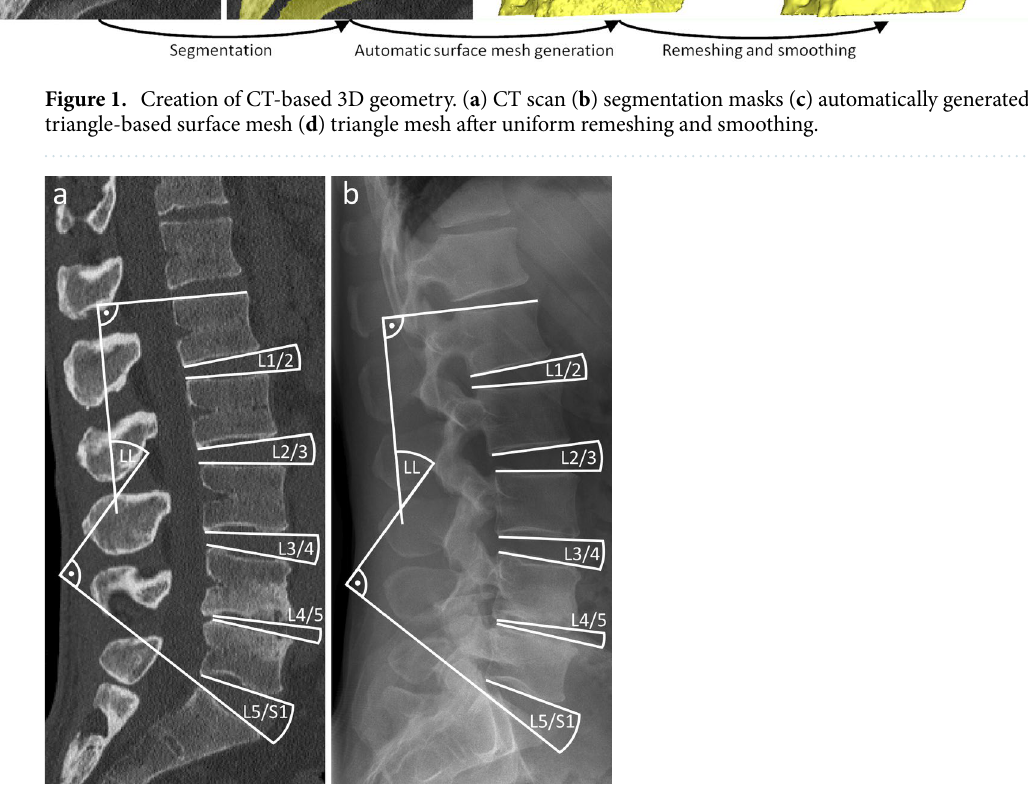
Figure 2. Measurement of intersegmental and LL angles in a ( a ) CT-scan and ( b )